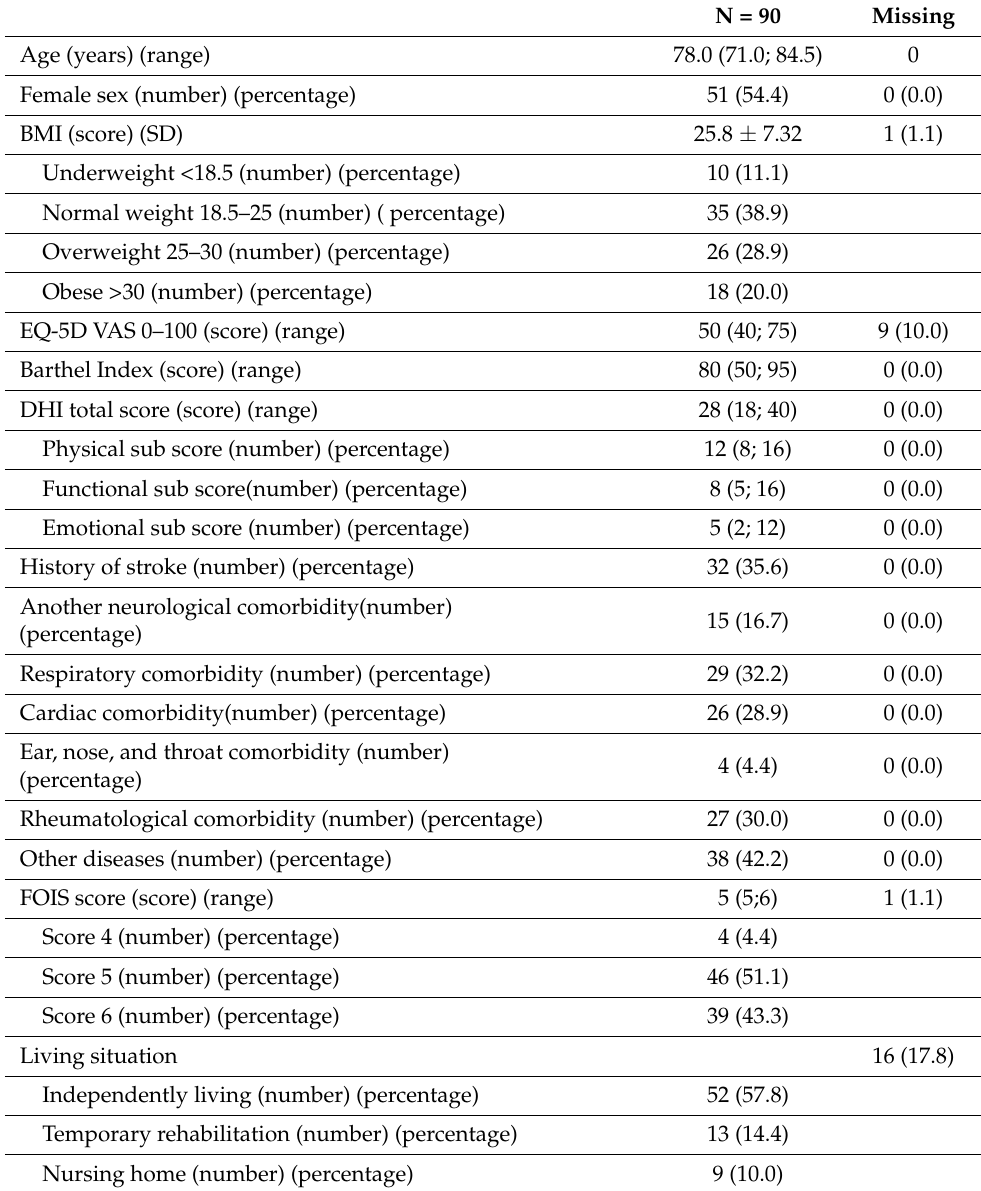
Table 1. Demographic